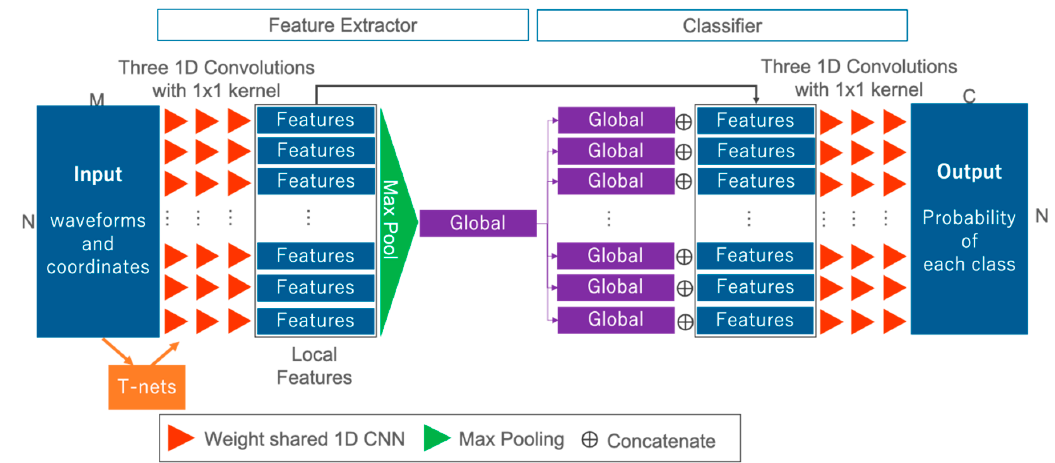
Figure 3. FWNet architecture. Input: waveforms and coordinates; output: class probability.